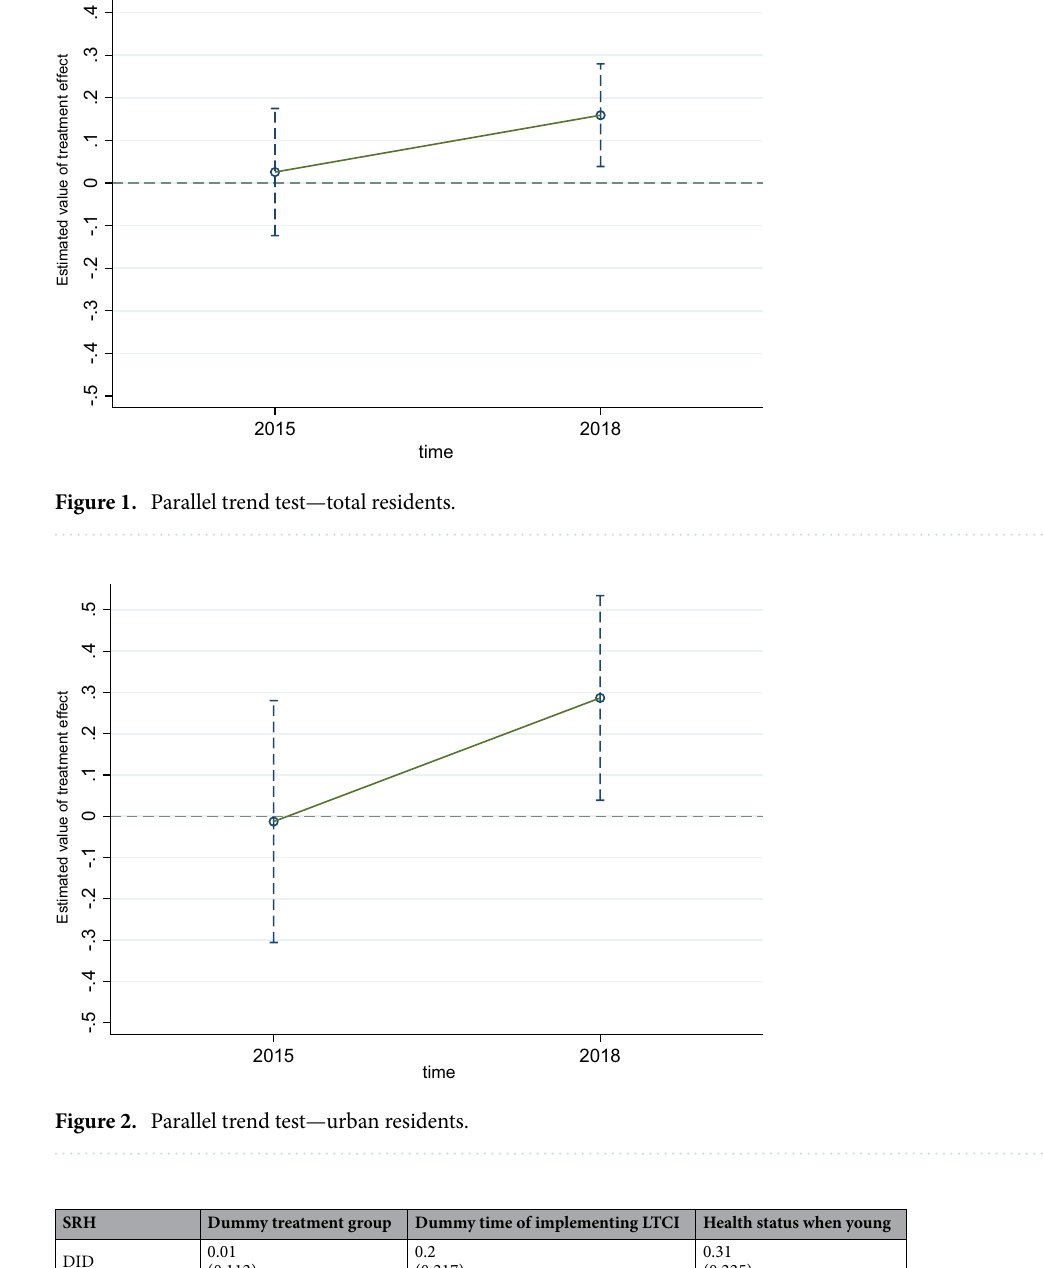
SRH Dummy treatment group Dummy time of implementing LTCI Health status when young DID 0.01